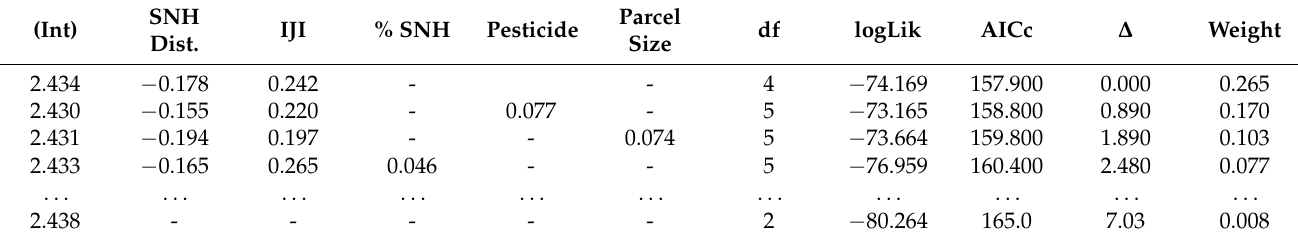
Table A4. Flying insect family richness model selection based on the comparison of their corrected Akaike Information Criterion-AICc with the dredge function (MuMin package of R version 4.0.2